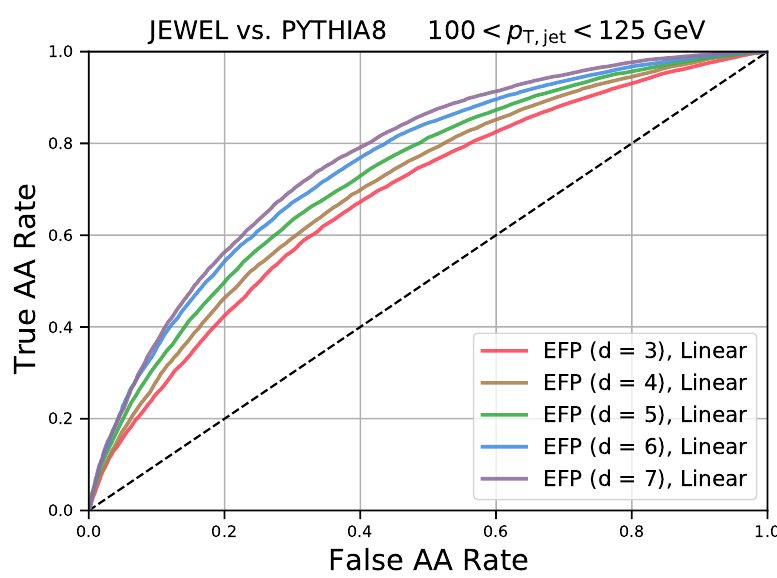
Figure 6 . ROC curves for jets in pp vs. AA collisions using the EFP basis up to degree